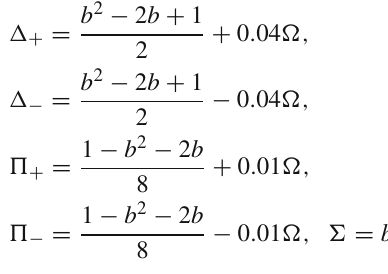
Fig. 11 Real, imaginary, and absolute values of the partition function as a function of a and b for the parameters { c = 1, d = 1, h = 0 } . The yellow surfaces represent the respective values of the partition function and the red surfaces represent the surface along which either a = b or b 2 − a 2 + 2 ab =